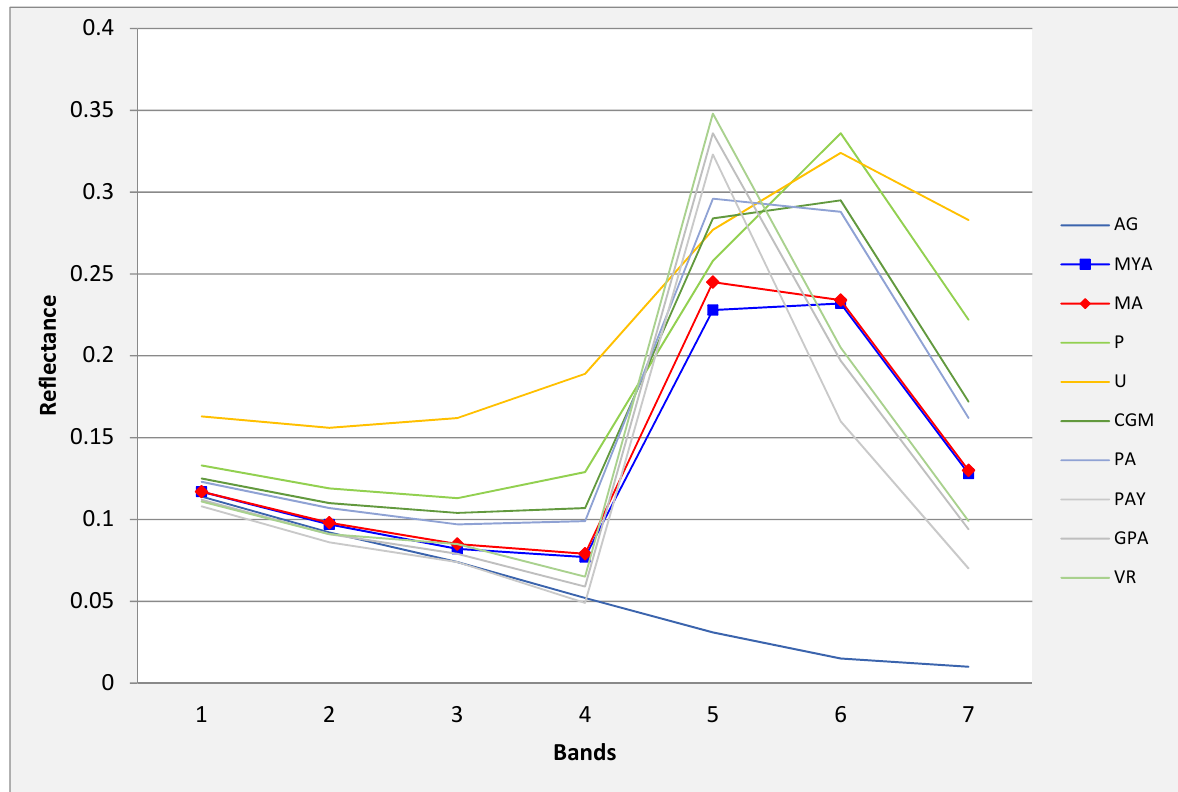
Figure 4. Spectral signatures of different vegetation and land-use categories in the Landsat-8 image of Trinidad-Valle de los Ingenios, Cuba.